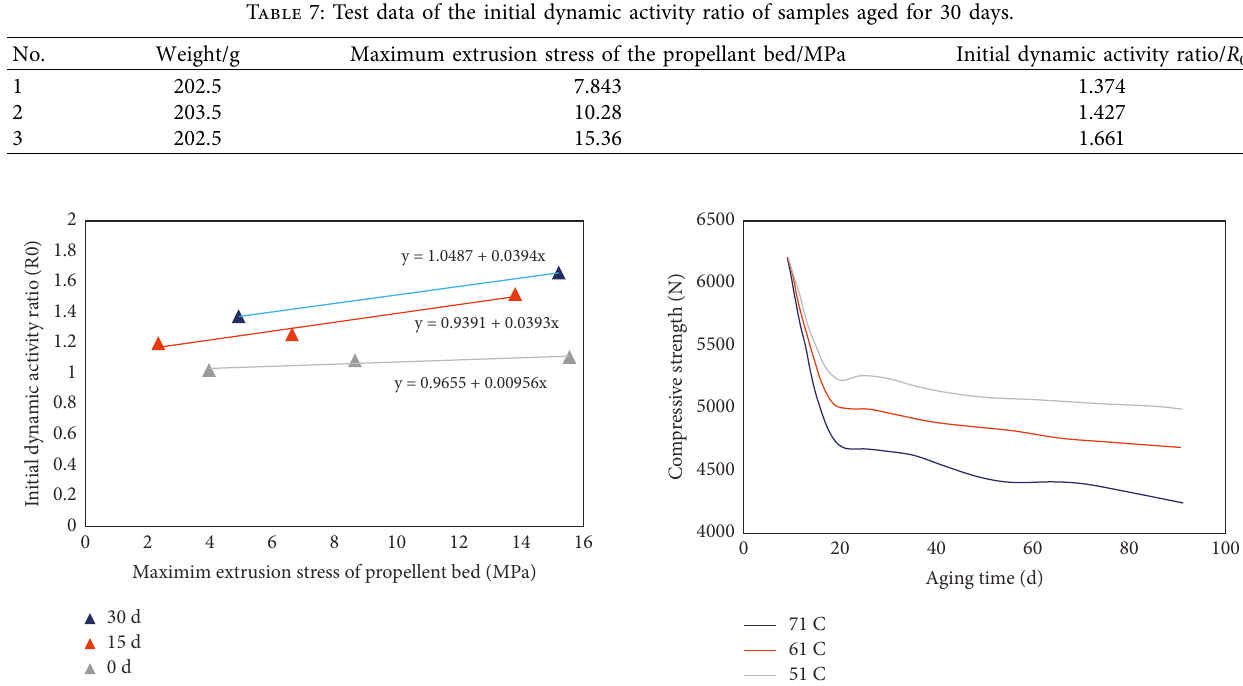
Figure 4: The initial dynamic activity ratio of samples with dif- ferent aging times.